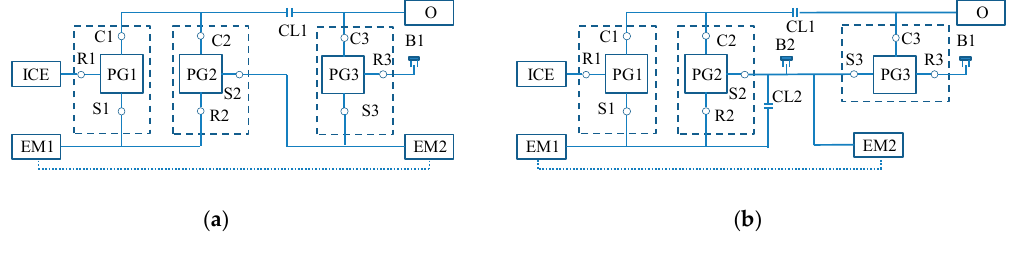
Figure 22. Type-d architecture: ( a ) GM AHS; ( b ) GM AHS2.